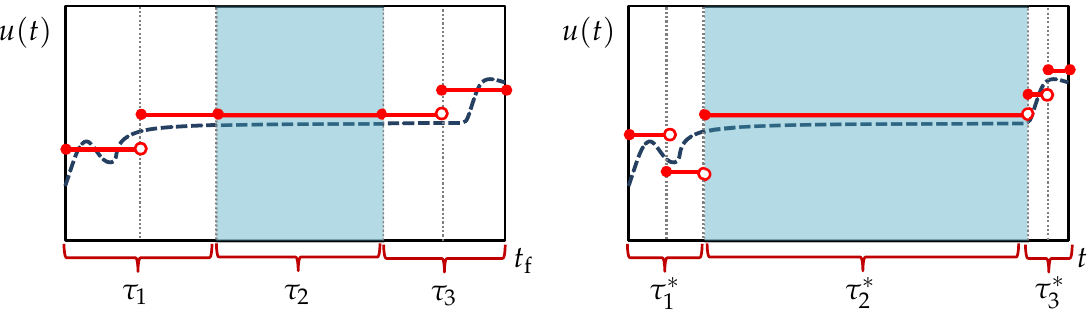
Figure 4. Adaptive semi-uniform discretization with suboptimal (left) and optimal (right) solution for τ i s. The dashed line trajectory shows the ideal optimal control as a reference.